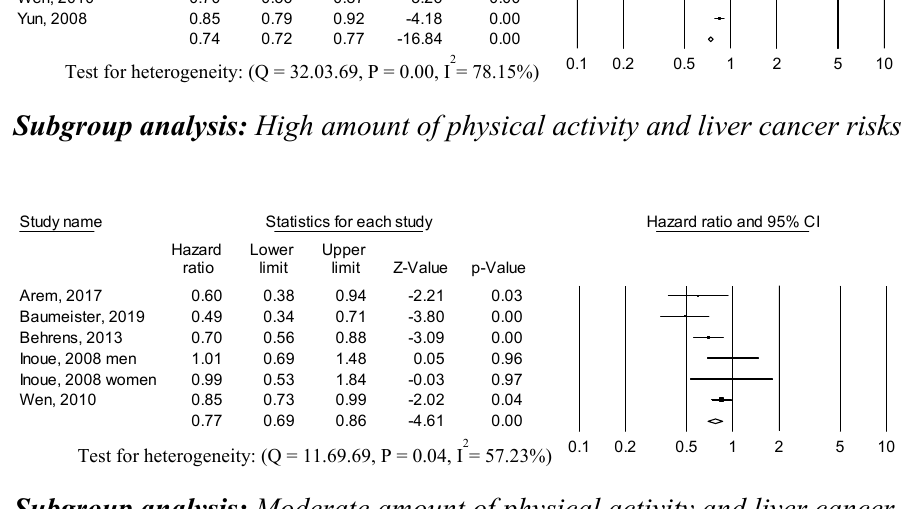
Figure 2. Physical activity and liver cancer risks